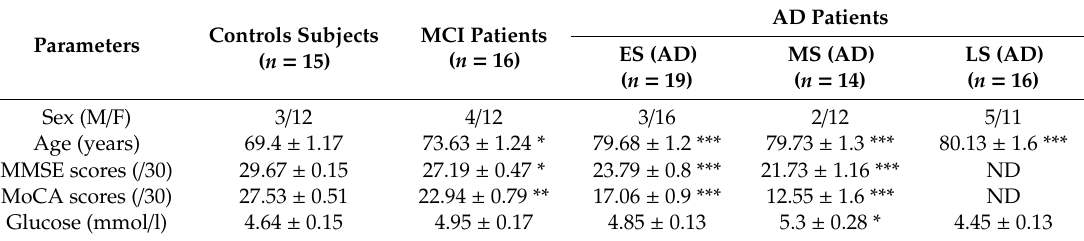
Table 1. Characteristics of control subjects, MCI and AD